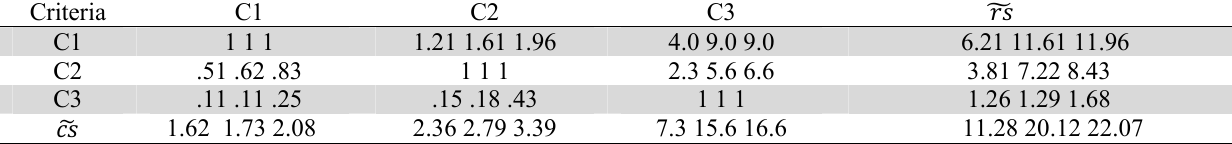
Table 3 Fuzzy Pair-Wise Comparison Matrix of the Component HoQ Criteria C1